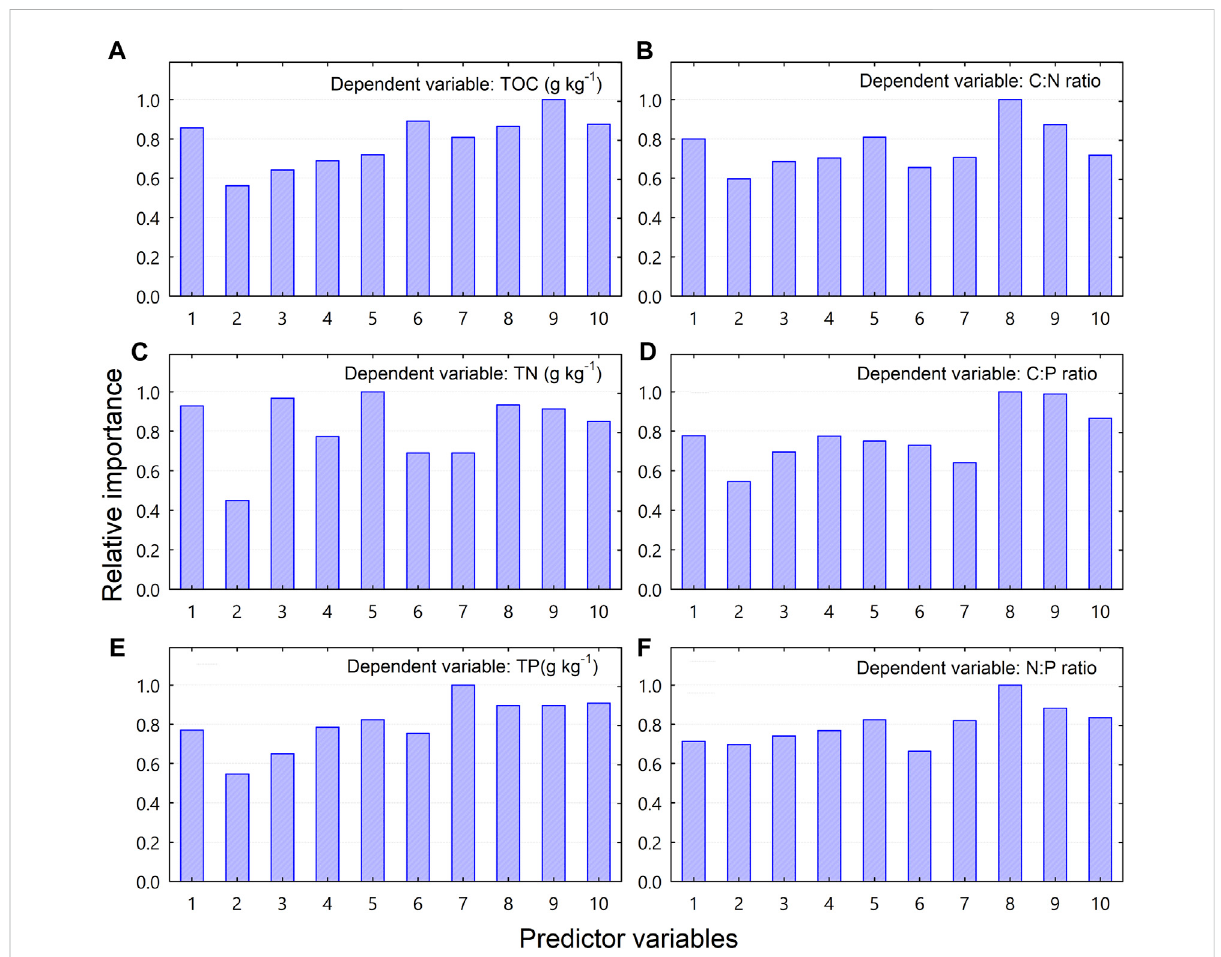
FIGURE 6 Relative importanceof vegetation-related variables in predicting soiltotal organic carbon (TOC),total nitrogen (TN), total phosphorus (TP),and C:N:PstoichiometricratiosasdeterminedbytheRandomForestregressionmodel.Codeforpredictorvariables:1=numberofstems;2=numberof species; 3 = number of stems per species; 4 = Shannon-Wiener index; 5 = Pielou ’ s evenness; 6 = Berger-Parker index; 7 = basal area; 8 = size diversity index; 9 = size-dependent evenness; 10 = size-dependent Berger-Parker